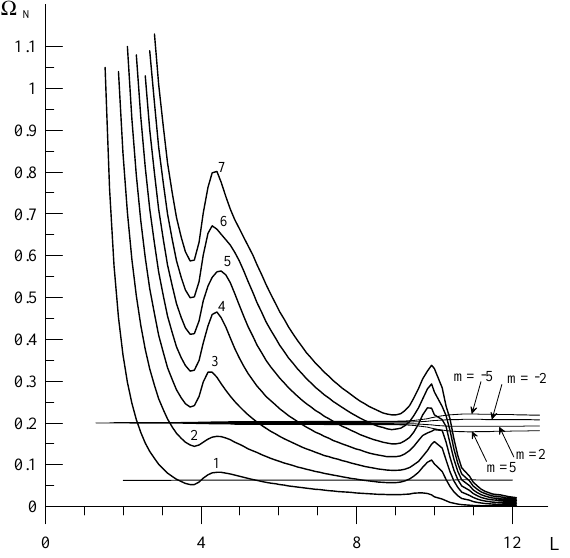
Fig. 4. The distribution of eigenfrequencies of the first harmonics of standing Alfv´en waves ( N = 1 , 2 ,..., 7) across magnetic shells and the value ¯ ω = ω − m(cid:127)(x 1 ) for f = ω/ 2 π = 10 − 2 Hz and m =± 2 , 5. The intersection points of these functions specify the location of resonant